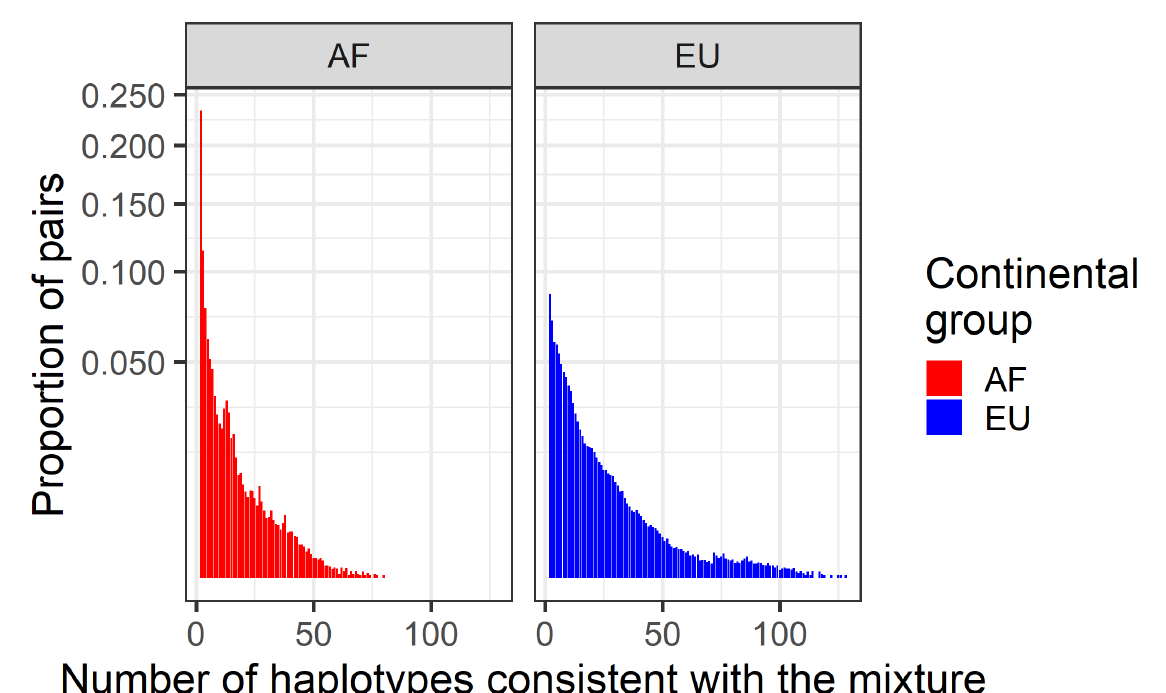
Figure 9. The proportion of haplotype pairs that explain two-person mixtures. Up to 100,000 in silico two-person mixtures were created using haplotypes from the Human Mitochondrial database (HmtDB). Mixtures were created within popula- tions taking pairs of individuals from the African (AF) and European (EU) continental groups (colors). The number of distinct haplotype pairs that can then explain the mixture were tabulated ( x -axis) as well as the frequency of the occurrence ( y -axis, square root scale). Haplotype sampling occurred with replacement, thus the minimum number of haplotype pairs that can explain the mixture is one.